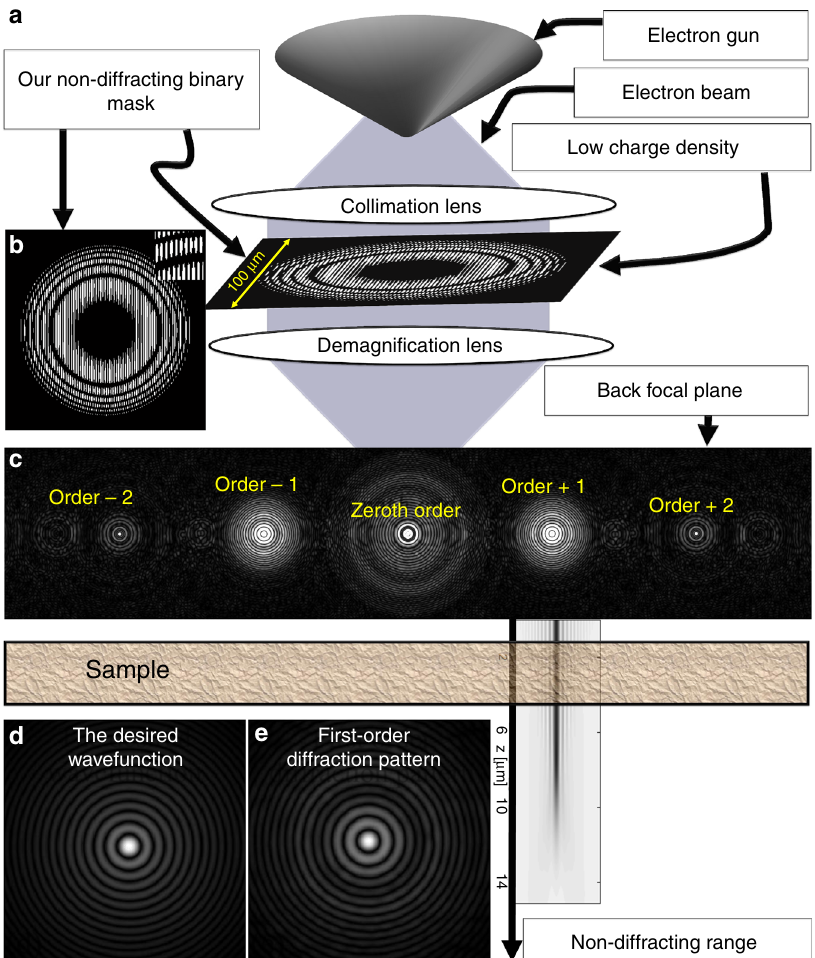
Fig. 2 Holographic generation of the shape-invariant wavefunction of multi-electron beams. a An electron beam is transmitted through a binary with the shape from Eqs (10 and 11). Then it is focused by a magnetic lens to the Fourier domain at the back focal plane. b Transmission function of the binary mask. c The diffraction pattern generated by passing a plane wave through this mask at the back focal plane. The center pattern is the zeroth-order diffraction pattern. The pattern on the left ( right ) of the zeroth order corresponds to the +1 ( − 1) diffraction order. This diffraction pattern shows that the diffraction patterns can be cleanly separated from one another, and that the ± 1 orders can be used to generate the non-diffracting wavefunction. d , e Comparison between the diffraction pattern obtained from the +1 order and the desired wavefunction for which the mask is designed. This demonstrates that a very good approximation of the desired wavefunction can be generated even with a binary mask fabricated with present technologies (of course adding a phase mask 8 would give an even better